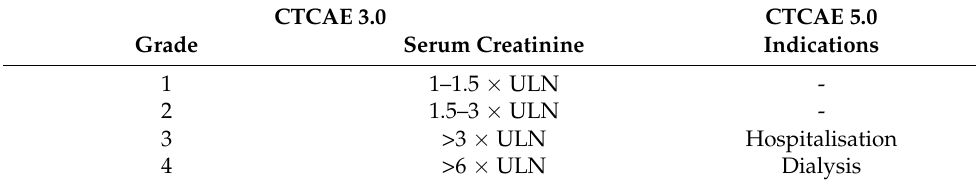
Table 3. CTCAE criteria for